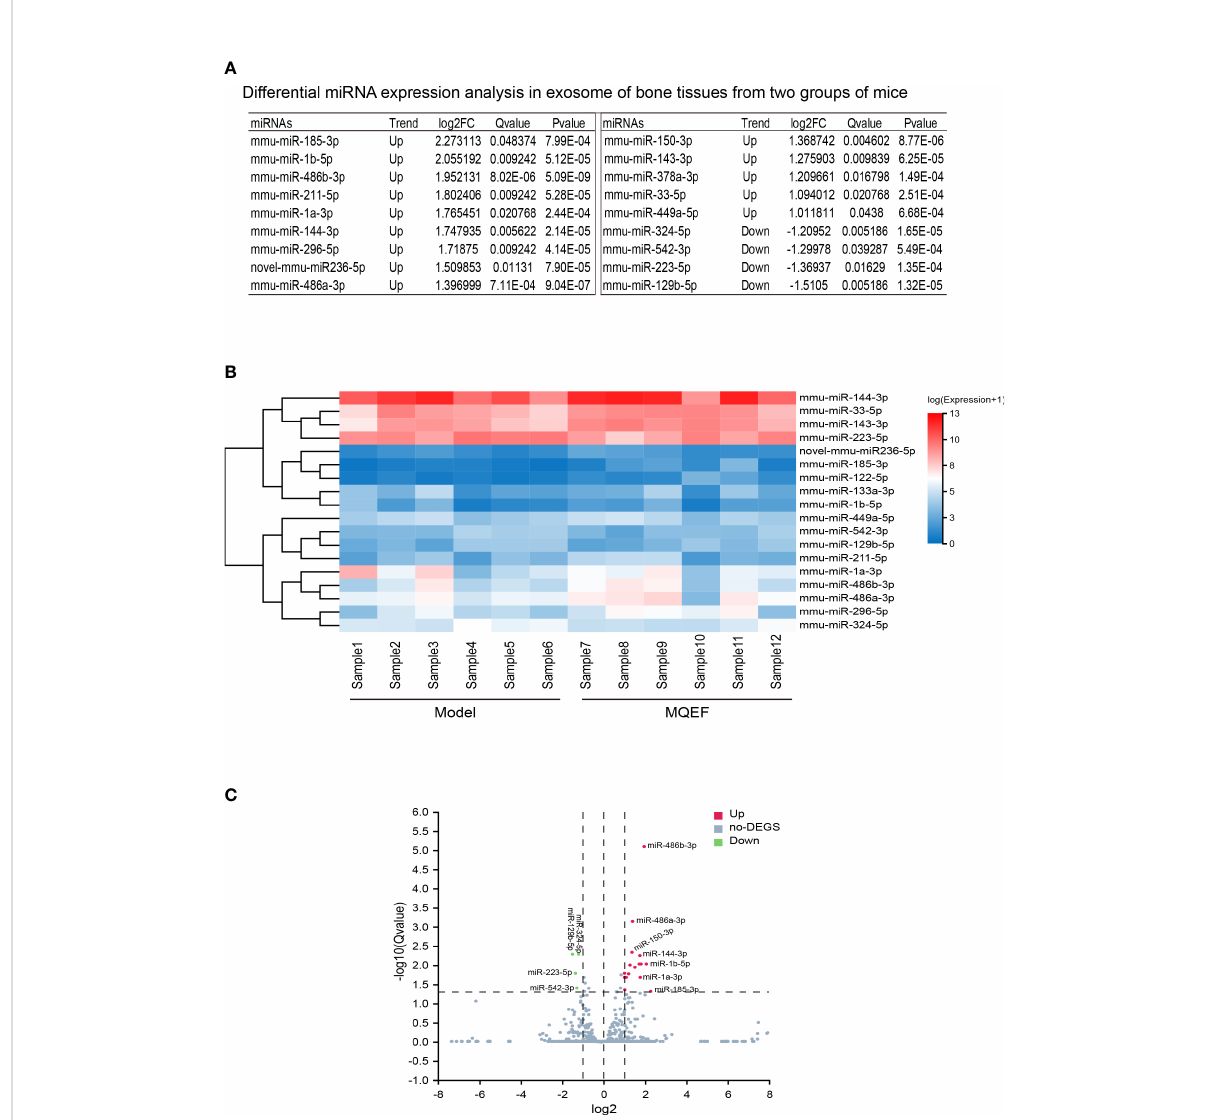
FIGURE 2 Differential gene display. (A) Differential miRNAs in bone tissue exosome sorted by LogFc. We ranked the measured miRNAs in the priority order of MiRbase > pirnabank > snoRNA (human/plant) > Rfam > other sRNA for annotation, and if none of the above databases were retrieved, they were de fi ned as novel miRNA. We de fi ned the signi fi cant difference threshold as log2FC>=1 and Q-value<=0.05. Based on statistical analysis, a total of 18 miRNAs expression was de fi ned having a difference between the two groups; (B) Differential gene heat map, the horizontal axis is log2 (expression value +1) of the sample, and the vertical axis is the gene. The redder the color of the color block the higher the expression, the bluer the color the lower the expression. (C) Differential gene volcano plot, the X-axis represents the log2-transformed differential fold value, and the Y-axis represents the -log10-transformed signi fi cance value. Red represents up-regulated DEGs, blue represents down-regulated DEGs, and gray represents